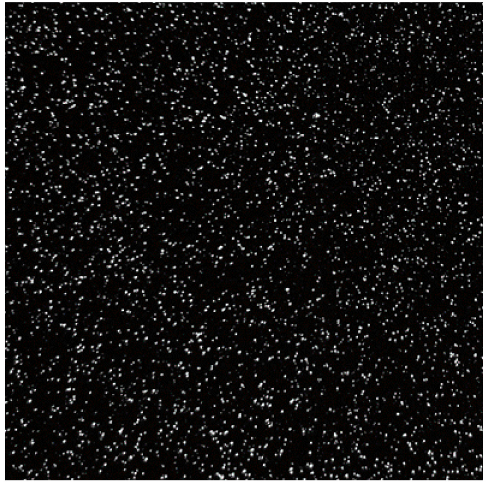
Figure 14. The sample image showing particle density.